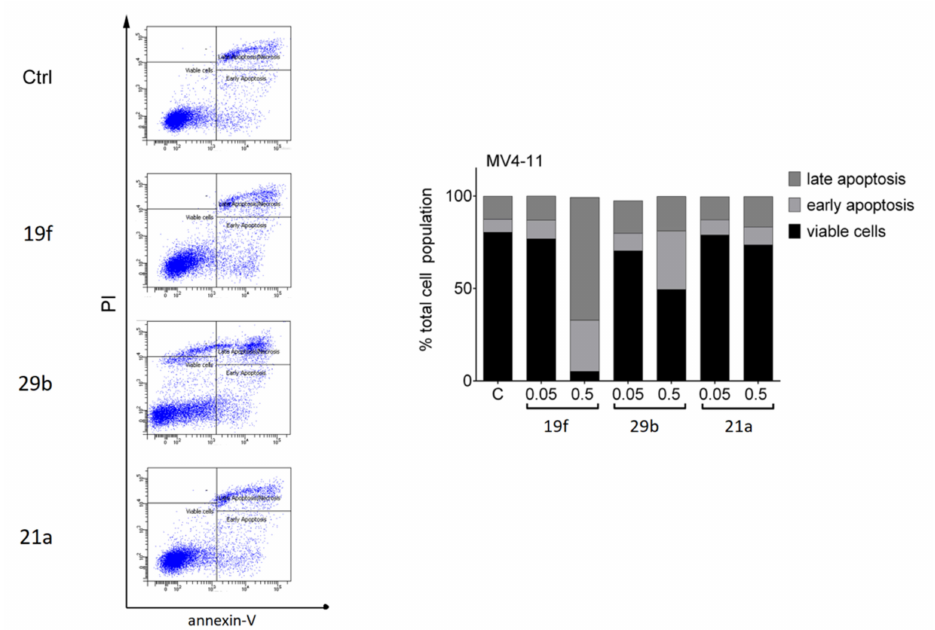
Figure 5. Impact of 19f, 21a and 29b on the survival of MV4-11 cells. The cells were treated with 0.5 µ M of 19f, 21a, and 29b for 48 h or solvent (Ctrl). The left panel shows the original flow cytometry scans (x-axis, annexin-V-FITC; y-axis, propidium iodide, PI). The right panel shows the percent- age distributions of intact, early apoptotic, and late apoptotic cells. Experiments were performed three times independently.